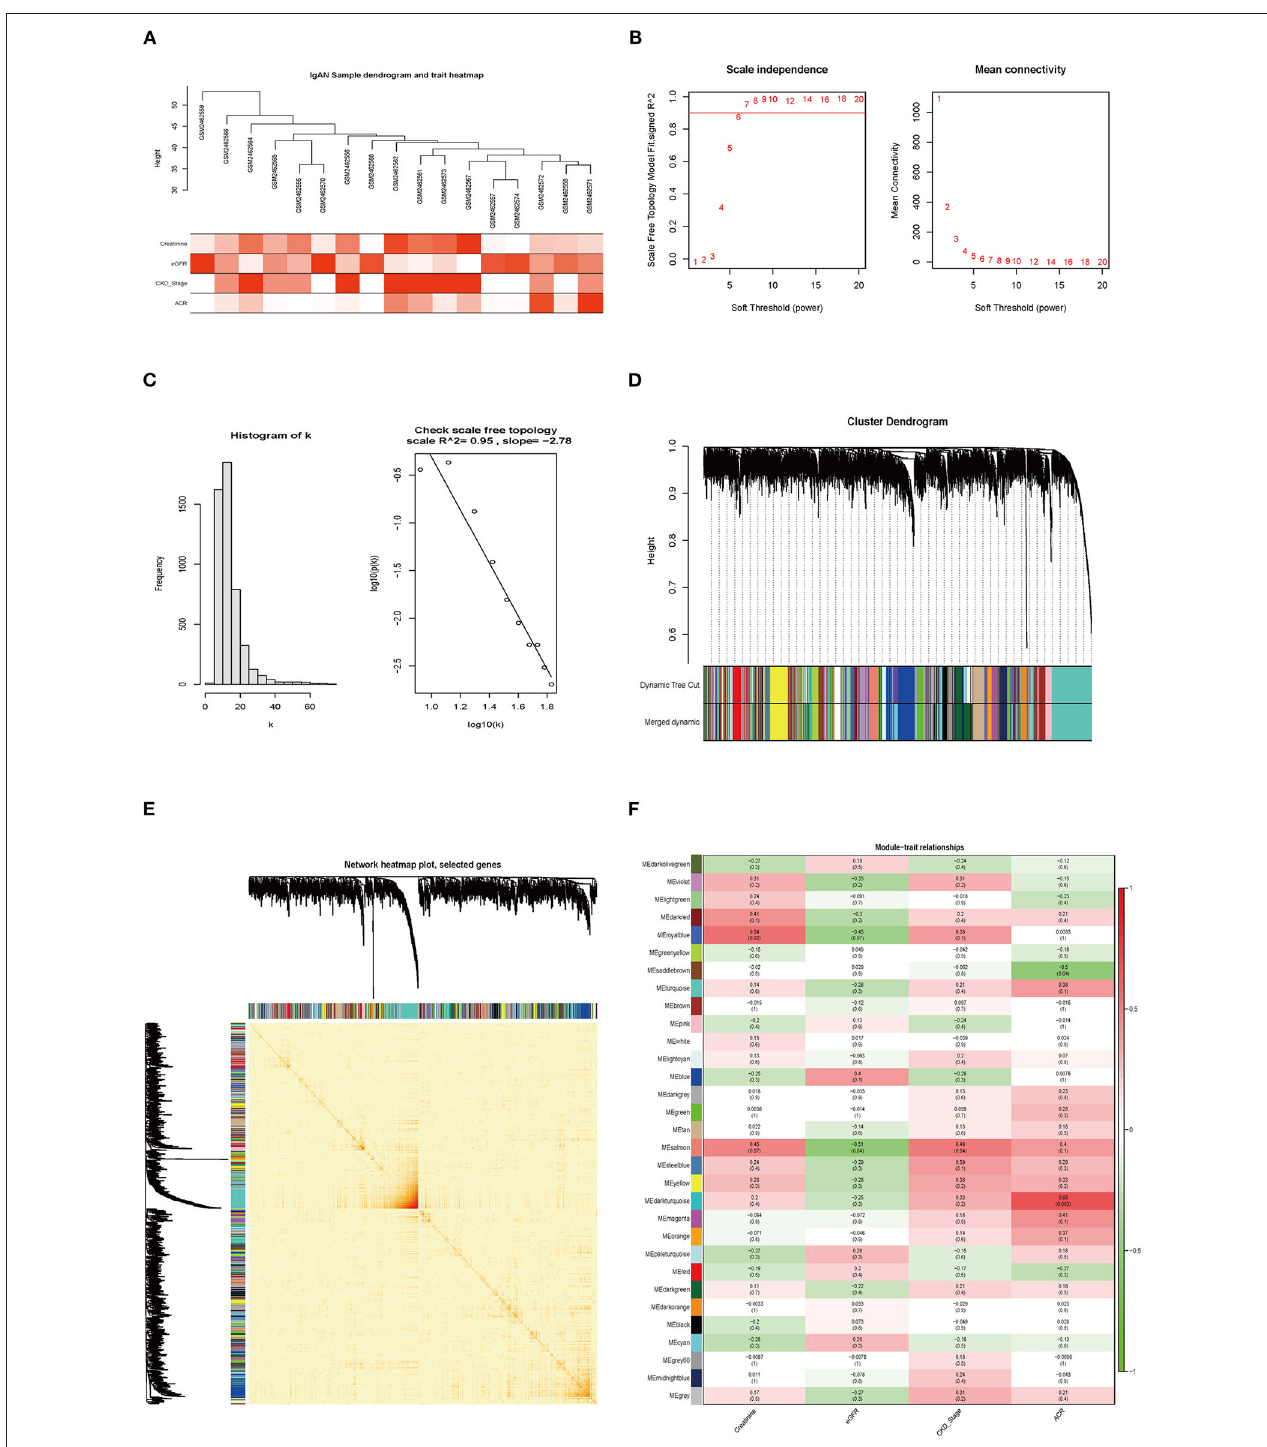
FIGURE 4 | Weighted coexpression network construction and identification of the key module. (A) Hierarchical clustering dendrogram of samples from GSE93798. Clinical features of renal function are shown at the bottom. (B,C) Analysis of the scale-free fit index and mean connectivity for various soft-thresholding powers. The scale-free topology was tested for β = 7. (D) Hierarchical clustering dendrogram of dissimilar genes based on topologic overlap. Modules are the branches of the clustering tree. (E) Heatmap of TOM of 1,000 selected genes in WGCNA; darker and lighter colors represent higher and lower degrees of overlap, respectively. The gene dendrogram and module assignment are shown along the left side and top. (F) Correlation between module eigengenes and clinical features of IgAN. Each row corresponds to a module eigengene and columns represent clinical features. Each cell contains the correlation and P -value. The royalblue module was closely related to indices of kidney function (creatinine and